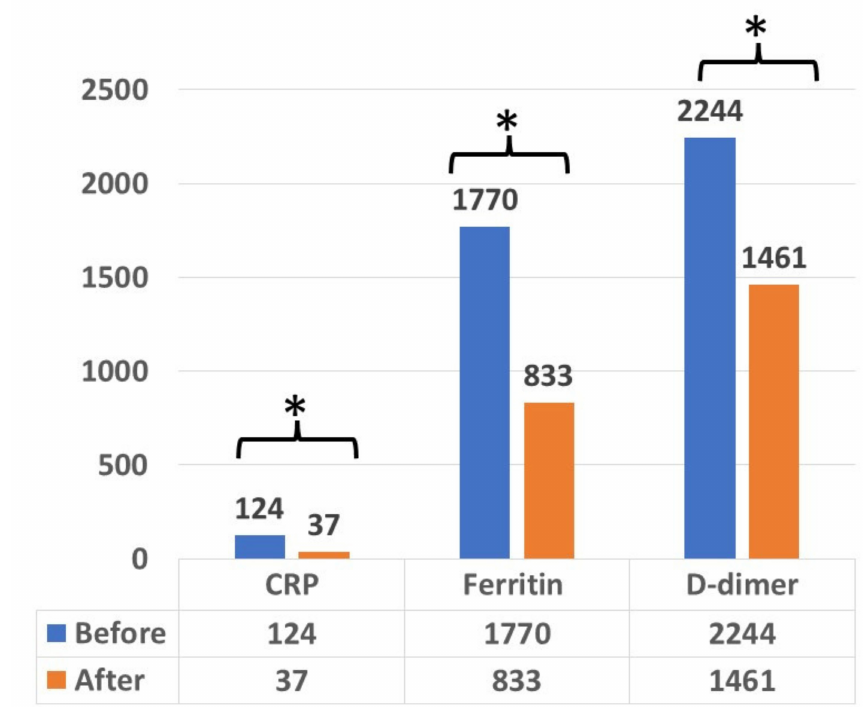
Figure 2. The effect of convalescent plasma on inflammatory markers (D-dimer, ferritin and CRP) in all patients treated with convalescent plasma. The measurements were done upon admission and 3–5 days after convalescent plasma perfusion. The asterisks mean the observed significance levels. ( p -value <